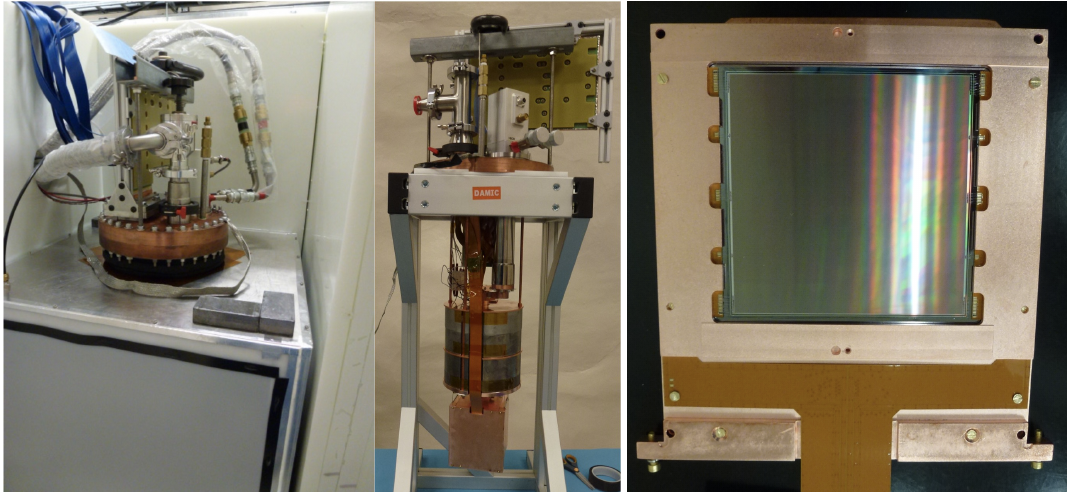
Figure 13: From left to right: Photographs of the DAMIC detector at SNOLAB show- ing the sealed copper cryostat inside its radiation shield, with electronics and service lines connected to the feedthrough flange, of the cryostat insert showing the Kapton flex cables running from the CCD box to the vacuum interface board along the chan- nel in the internal lead shield, and of the DAMIC CCD module housing a 4k x 4k pixel CCD. Figures from Refs. [ 67,68 ]